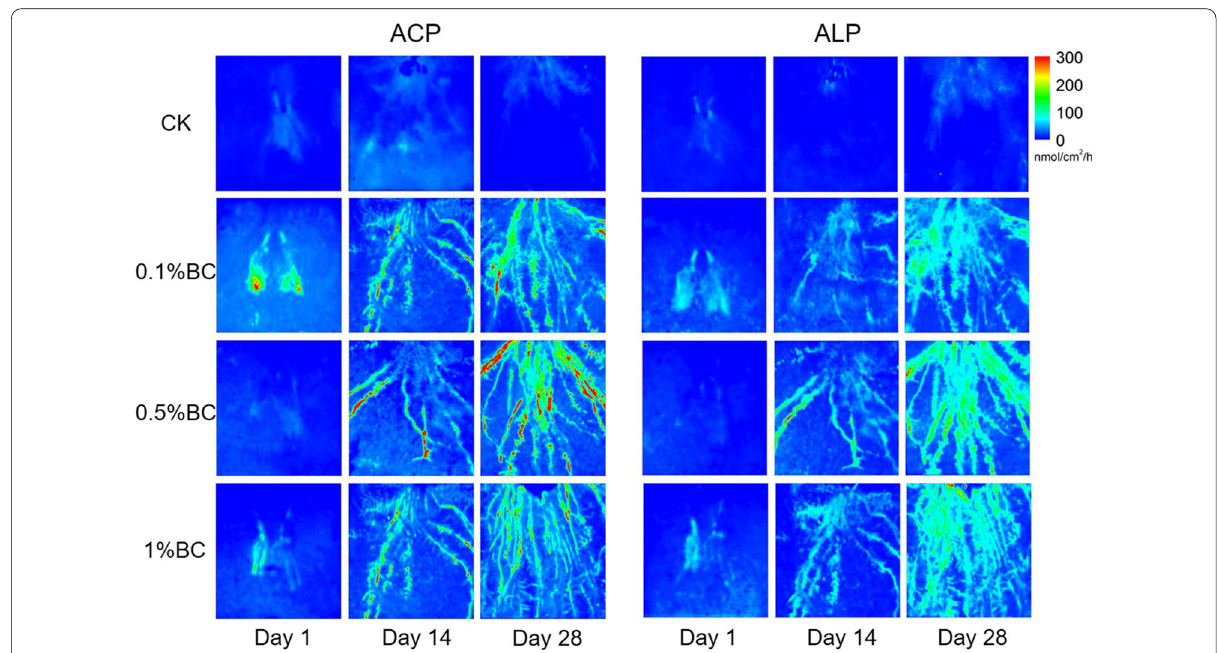
Fig. 3 Examples of in-situ zymography for soil acid and alkaline phosphatase activities in the paddy soil around rice roots at rice seedling stage under four biochar treatments under greenhouse pot experiments on days 1, 14, and 28. Four rows represent response of activities to four biochar amendment treatments: (1) CK, (2) 0.1%BC, (3) 0.5%BC, and (4) 1%BC. Figures from left to right are the measurements on days 1, 14, and 28. The color bar corresponds to phosphatase activities (nmol cm − 2 h − 1 ). CK, 0.1%BC, 0.5%BC, and 1%BC are referred as biochar addition rates at 0, 2.25, 11.25, and 22.5 t ha − 1 ,